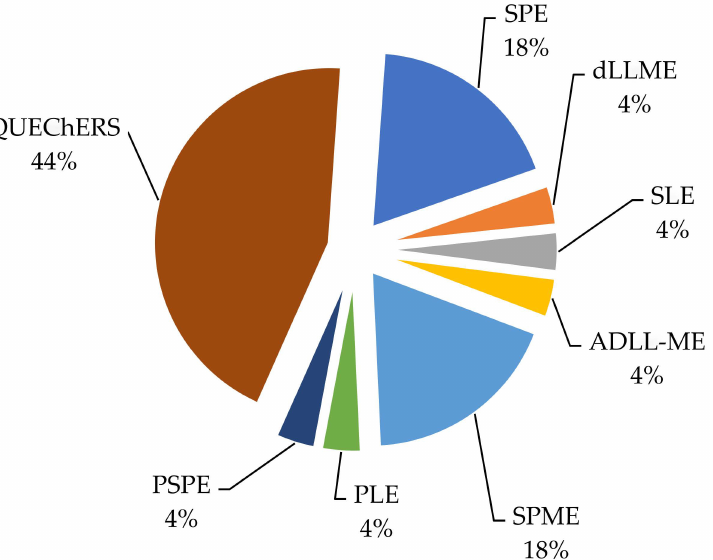
Figure 3. The most used methods of sample preparation and extraction in the determination of pesticides in